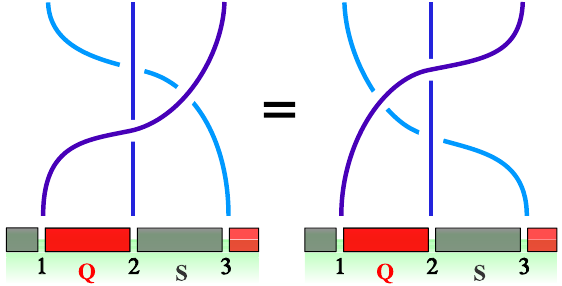
FIG. 3. Diagrammatic representation of the Yang-Baxter equa- tions [Eq. (27)]. Three interfaces 1, 2, 3 are braided in two distinct sequences. The Yang-Baxter equations state that the results of these two sequences of braiding operations are the